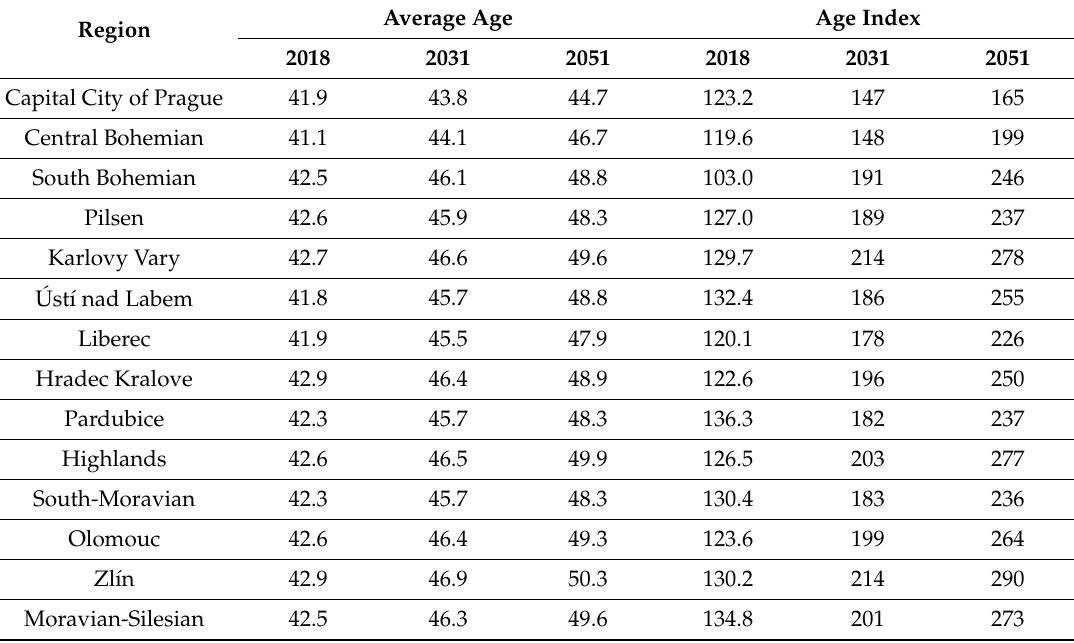
Table 3. Selected demographic indicators for the Hradec Kralove region (2018).